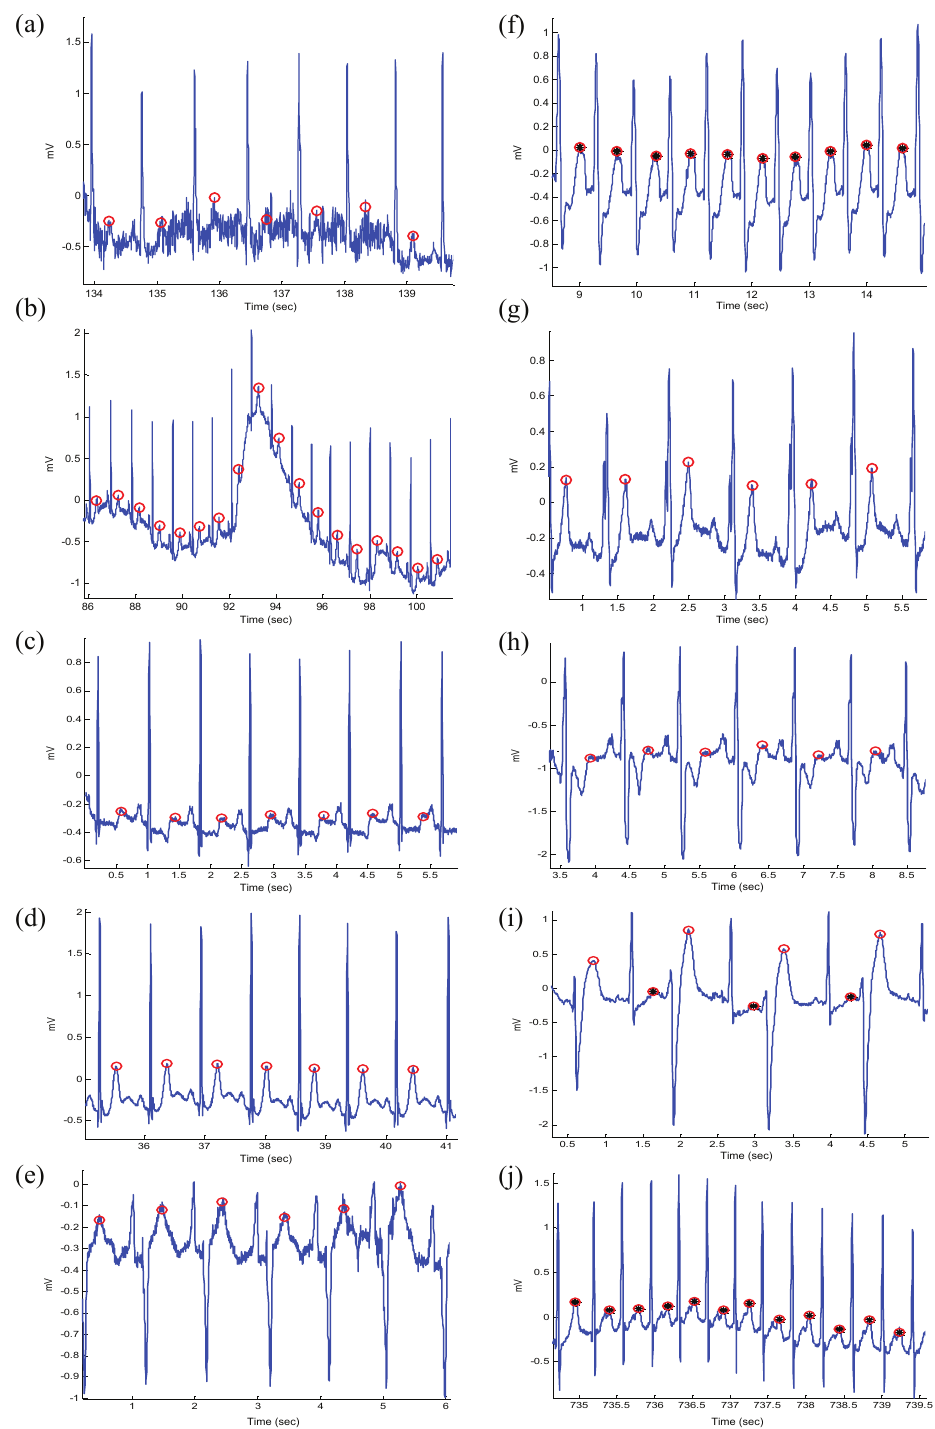
Figure 9. Demonstrating the performance of the proposed T wave detection algorithm on the MIT-BIH Arrhythmia database. The algorithm succeeds to detect T wave peaks in electrocardiogram (ECG) signals that contain: ( a ) high-frequency noise; ( b ) baseline wander; ( c ) normal sinus rhythm without U waves; ( d ) normal sinus rhythm with U waves; ( e ) normal sinus rhythm with negative polarization; ( f ) left bundle branch block (LBBB) beats with merged P and T waves; ( g ) LBBB beats; ( h ) right bundle branch block (RBBB) beats from record 118; ( i ) premature ventricular contraction (PVC) beats from record 200; ( j ) premature atrial contraction (PAC) beats from record 209. Here, the empty red circle represents the detected T wave while the a circle with a black asterisk represents detection of merged P and T